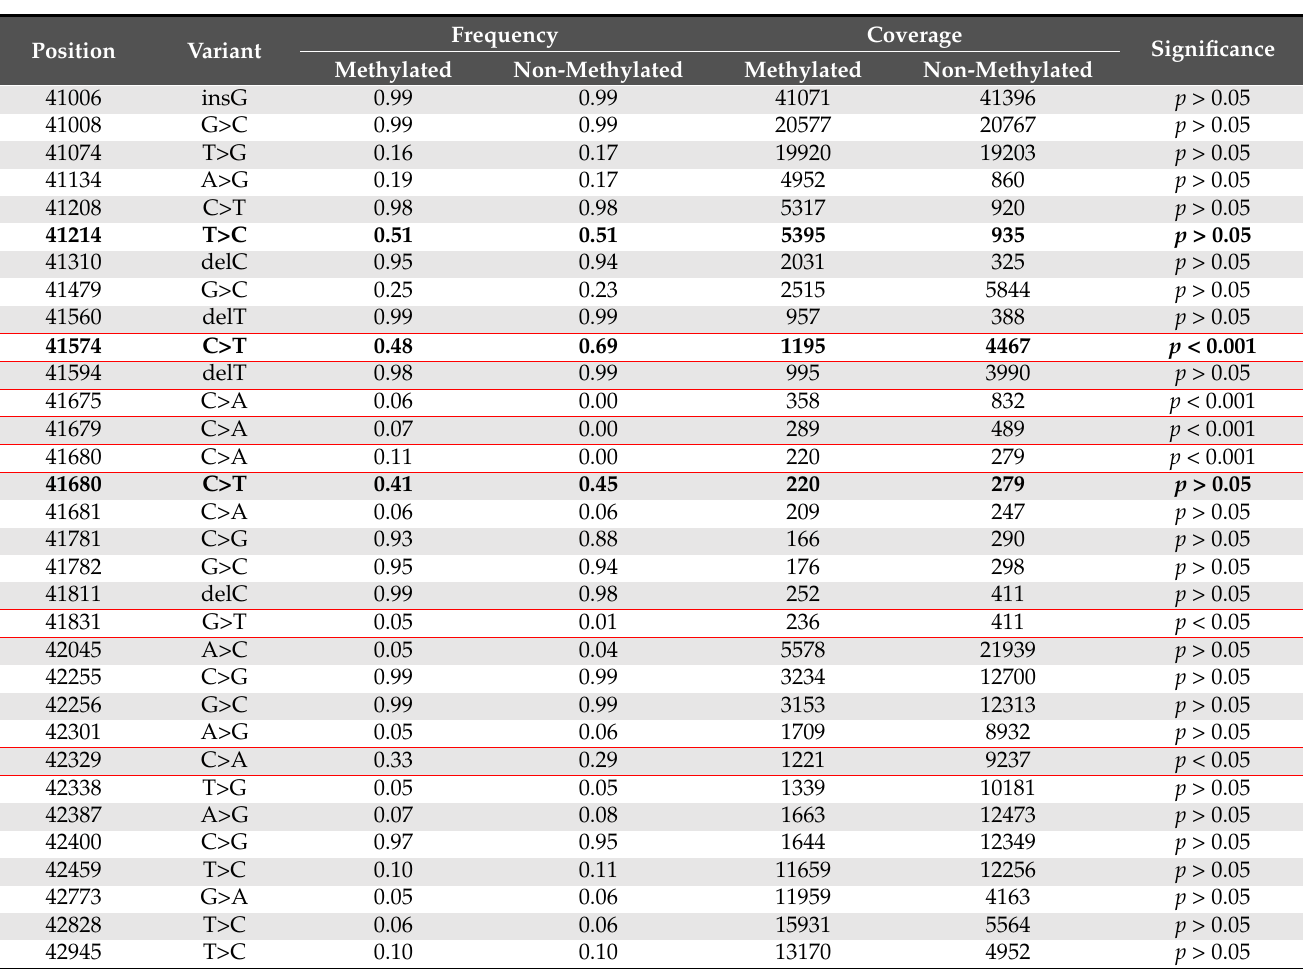
Table 1. SNVs and simple indels in the methylated/non-methylated rDNA. Variants with significant difference of methylated and non-methylated state are framed in red. Hot spots of variation are in